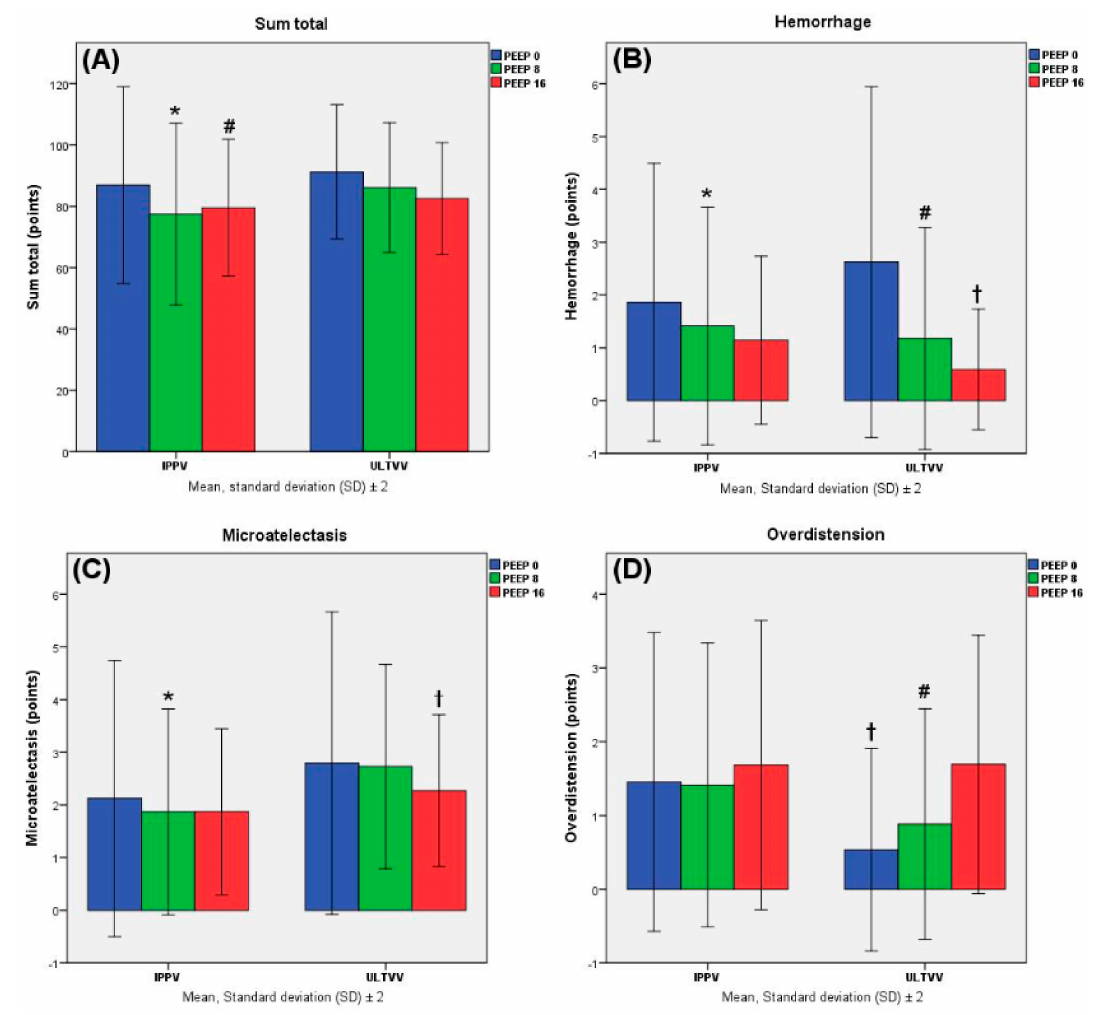
Figure 4. Lung histology evaluated with the DAD score. Categories were scored in points. Data are shown as mean values and standard deviation (SD). Significant differences in sum total ( A ): * vs. I0, p = 0.012; # vs. I0, p = 0.040 (linear mixed-effect models). Significant differences in haemorrhage ( B ): * vs. I0, p = 0.049; # vs. U0, p = 0.013; † vs. U0, p < 0.001 (linear mixed-effect models). Significant differences in microatelectasis ( C ): * vs. I0, p = 0.016; † vs. U0, p = 0.013 (linear mixed-effect models). Significant differences in overdistension ( D ): † vs. U16, p < 0.001; # vs. U16, p = 0.001 (linear mixed-effect